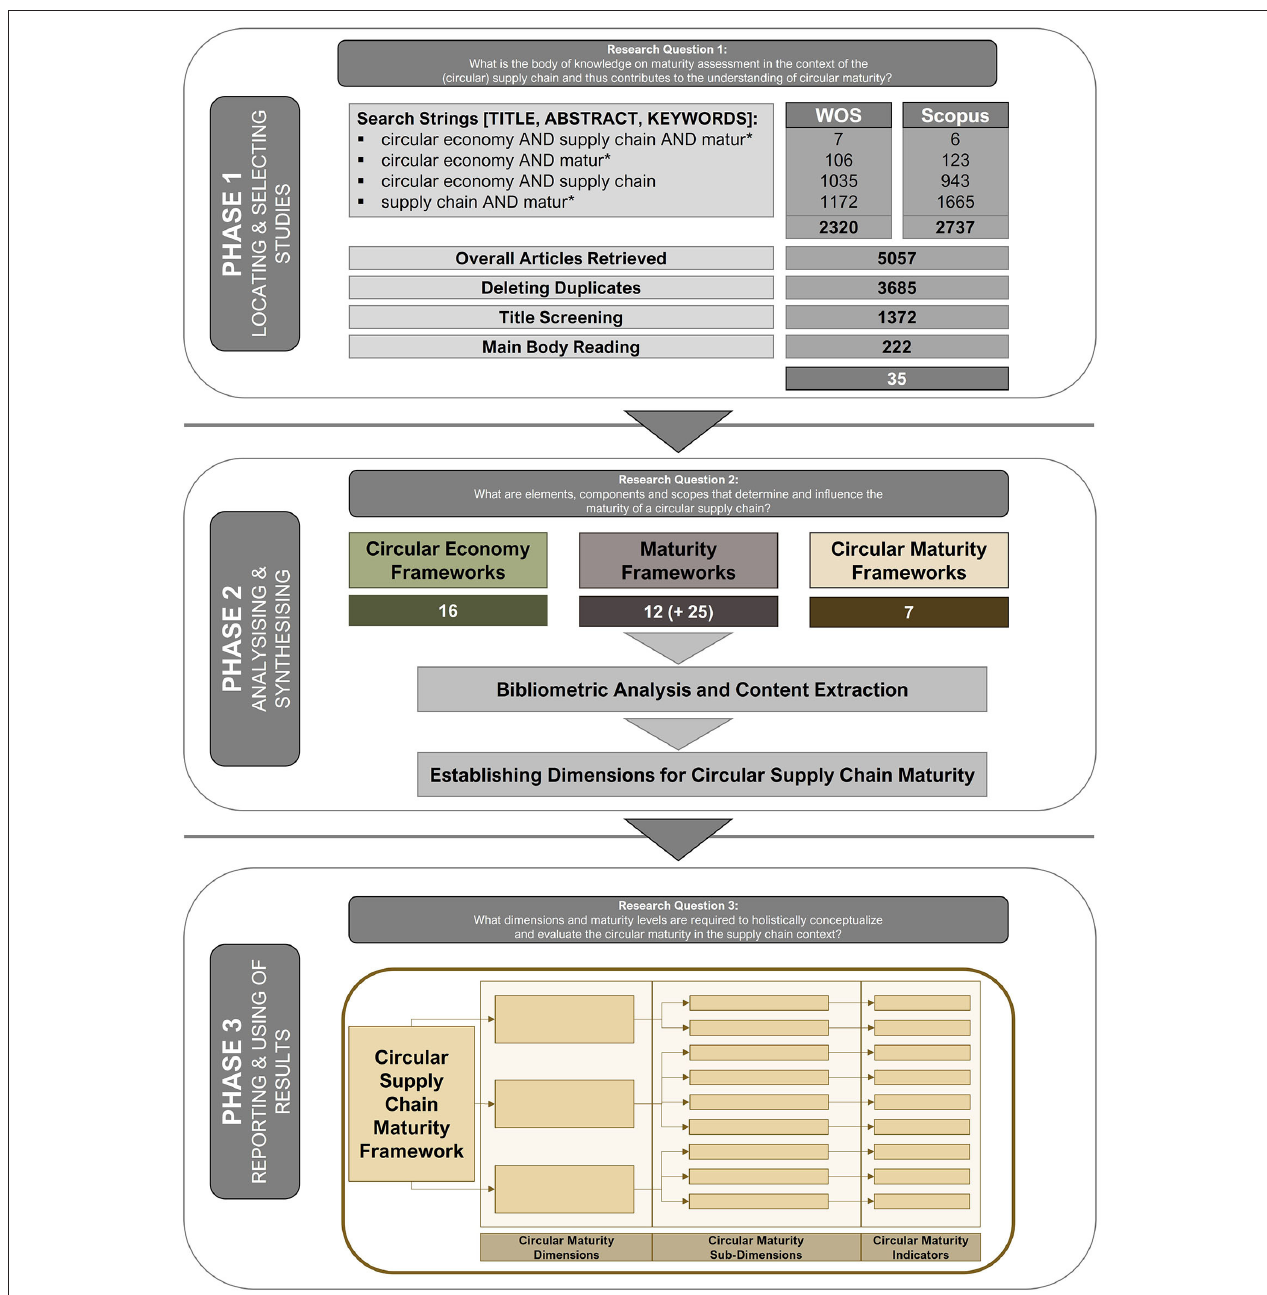
FIGURE 4 | Research